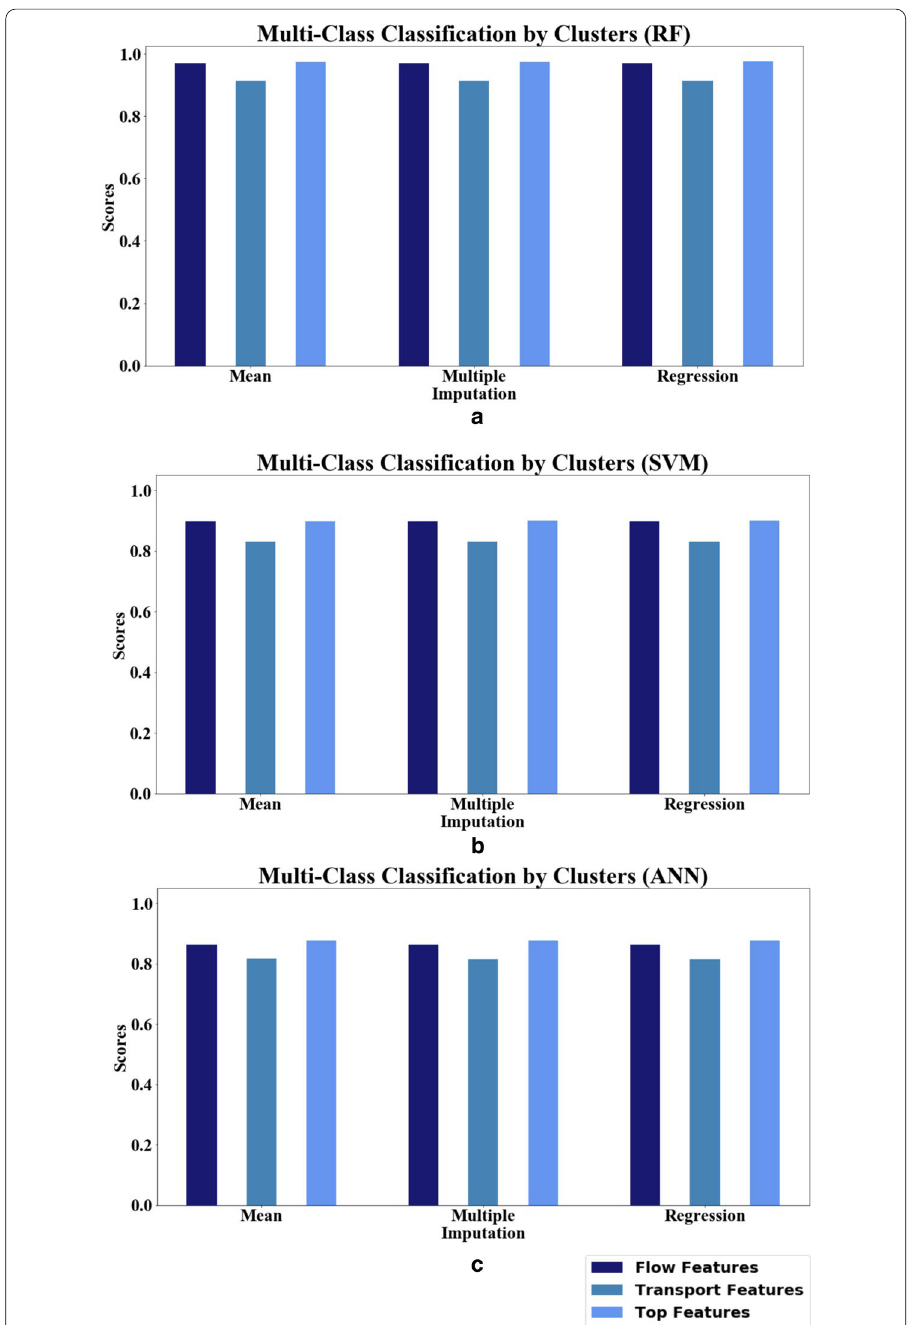
Fig. 8 Multi-class classification comparison of feature clusters In this figure, three sub-graphs of RF, SVM and ANN show classification results over three clusters. By using the top features cluster, the classification generally out-performed the other two clusters in terms of accuracy with lesser number of